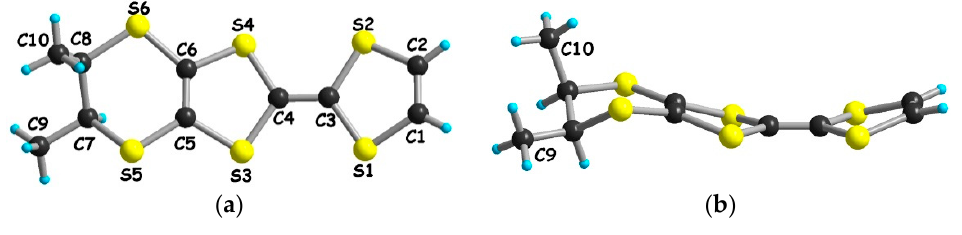
Figure 10. ( a ) Molecular structure of ( meso )- 2 ; ( b ) Lateral view.